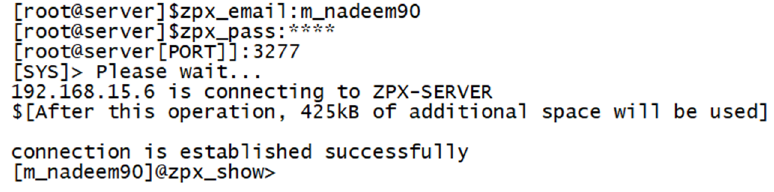
Figure 3. Cloud Server accessibility.